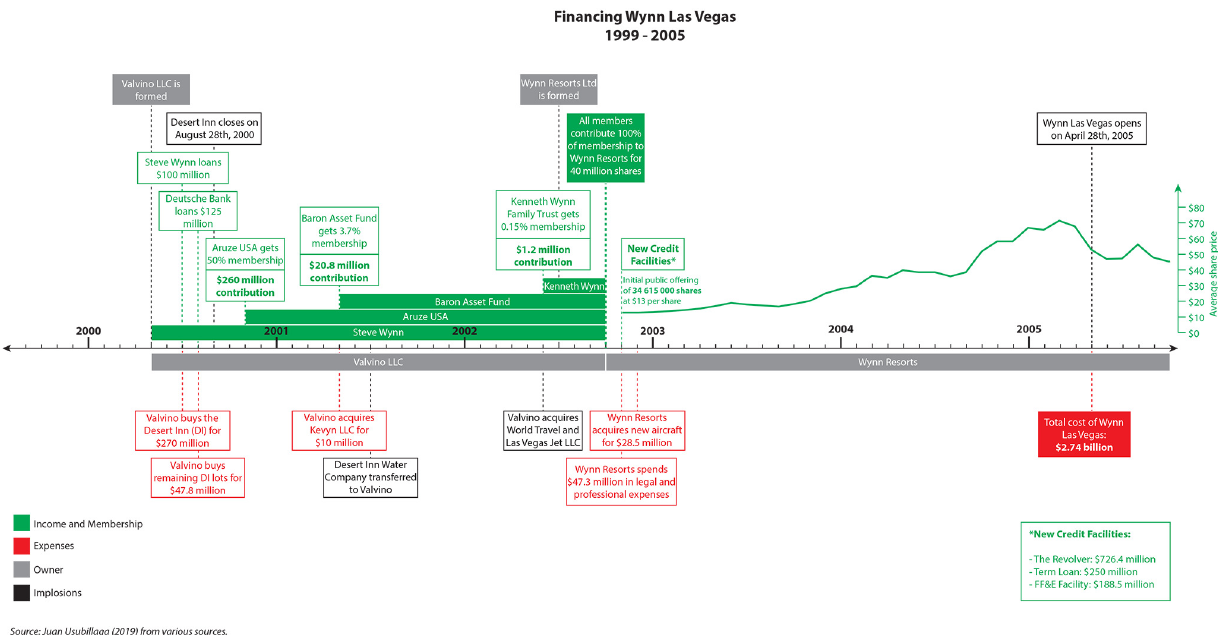
Figure 7. Financing fits‐and‐starts type of urban change can be complex, time‐consuming, and frequently requires mul‐ tiple sources: Timeline of financing the new $2.74 billion Wynn Las Vegas casino‐hotel‐resort. Source: Courtesy of Juan Usubillaga, based on Wynn Resorts Limited (2003–2019). and two theatres, Wynn Theater and Broadway Theater, which opened later in August 2005 (see Figure